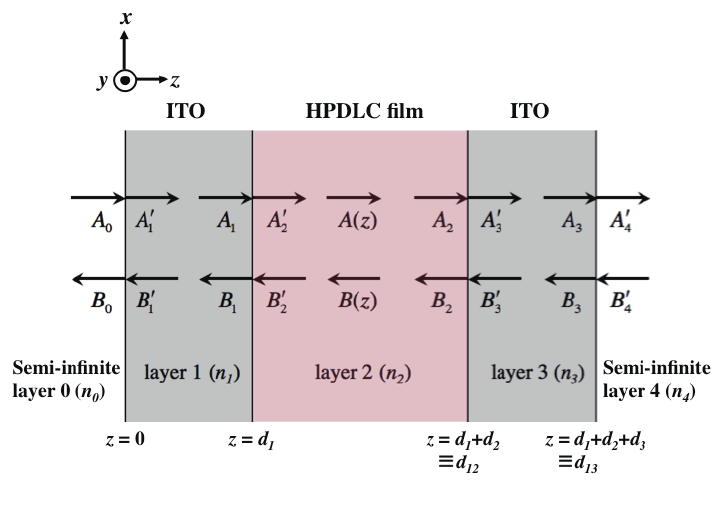
Figure 2. Three-layer system for the